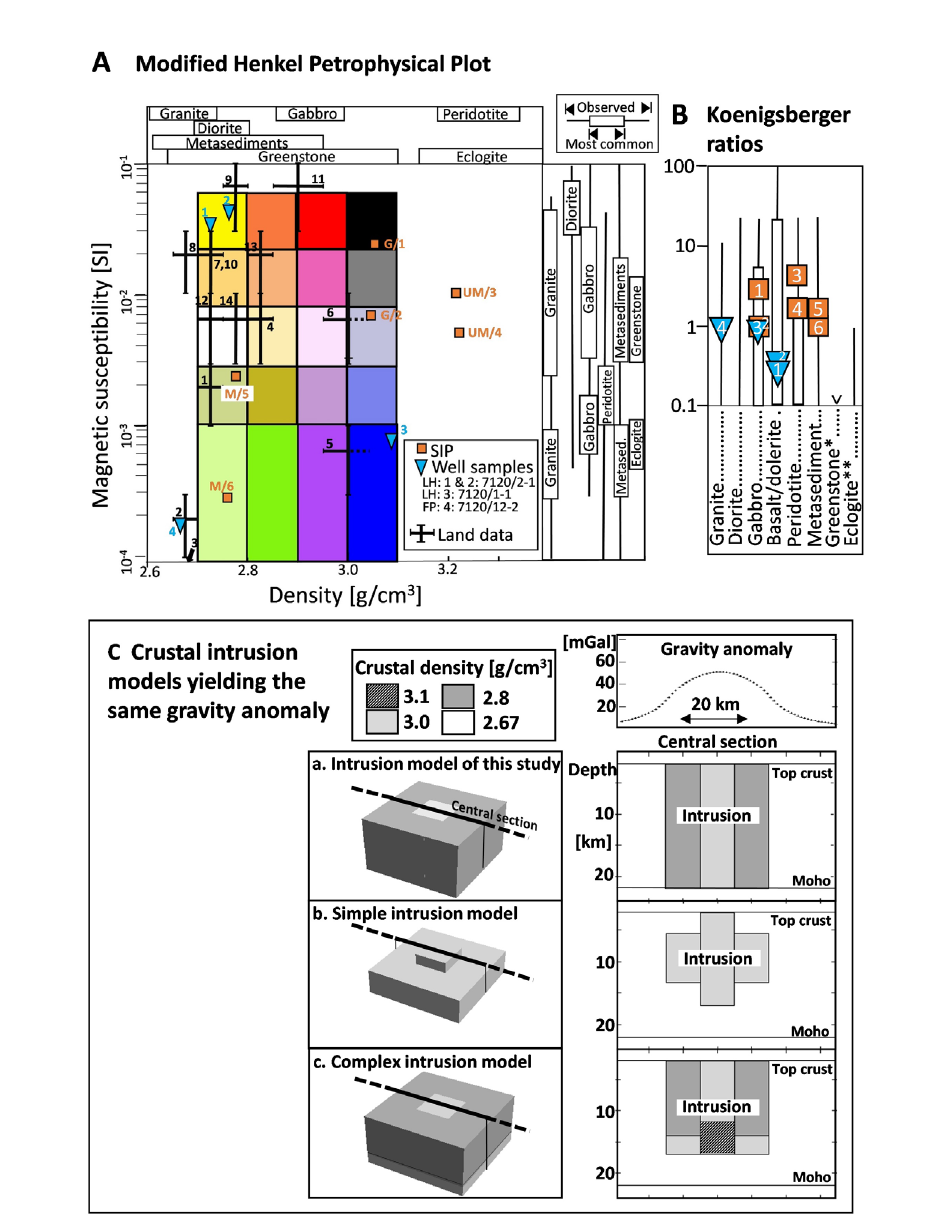
Figure 11. (A) Modified Henkel Petrophysical Plot (mHPP) with ranges of rock densities (Hinze et al., 2013) and magnetic susceptibilities (Henkel, 1991; Enkin et al., 2020; Clark, 1997; Olesen et al., 2010), rocks of the adjacent mainland (location by numbers in Fig. 13C; Table 3), crustal well cores (location by red and blue triangles in Fig. 13A; Table 3), and average values from the SIP–Seiland Igneous Province (Pastore et al., 2018; Table 3). (B) Koenigsberger ratios (Clark, 1997) with additional values from northern Scandinavia marked by “*” (Olesen et al., 2010) and by “**” (Henkel, 1991). (C) Different (crystalline) crustal density models which yield the same gravity anomaly (calculated at mean sea